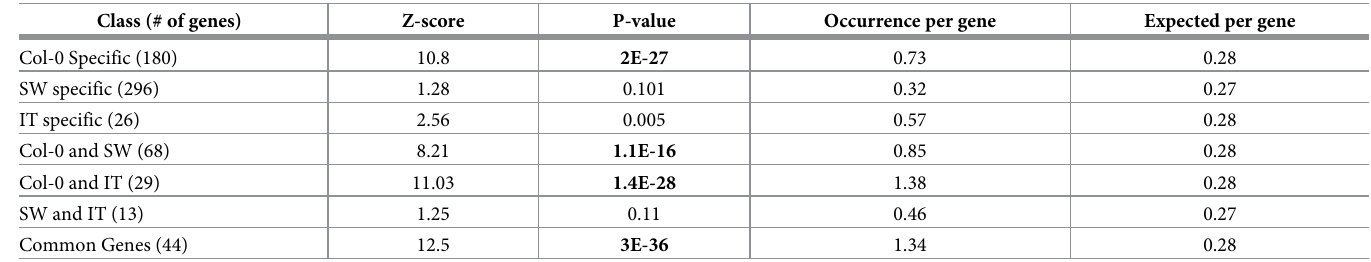
Table 2. Enrichment of the CBF-binding motif